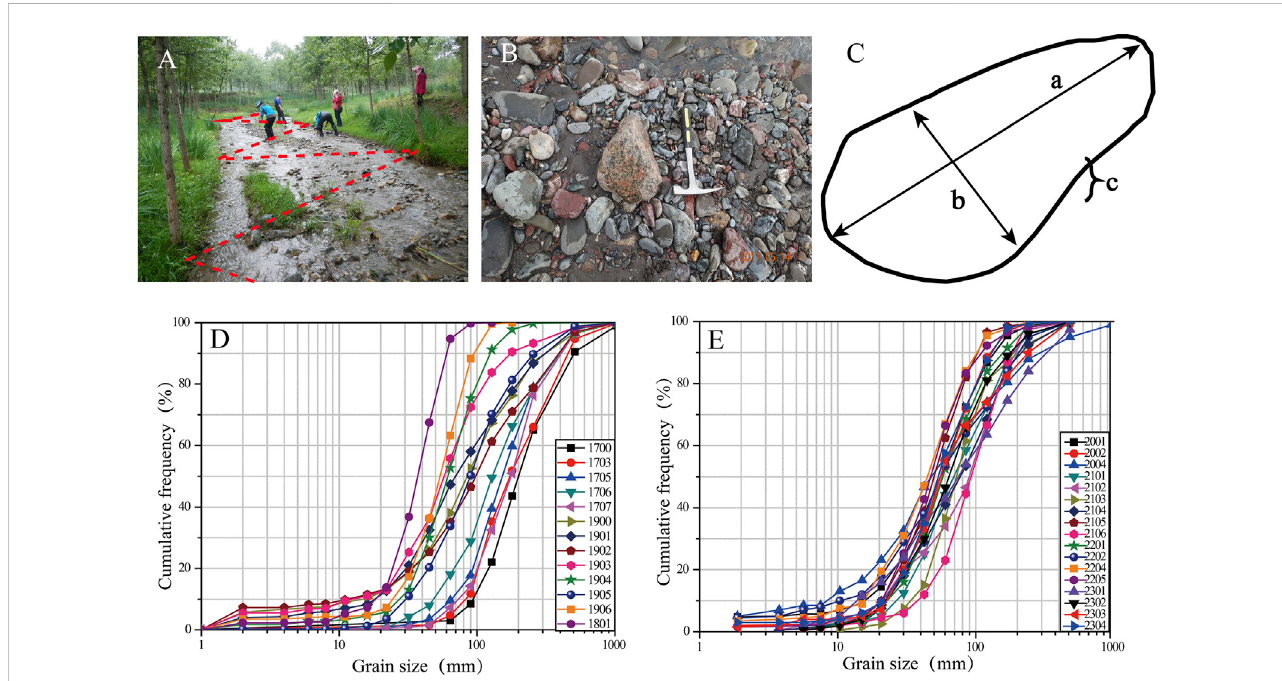
FIGURE 2 Diameter measurement method and fi eld photographs of channel sediments. (A,B) show fi eld survey methods and photos; (C) : Measuring shaft “ B ” axis; (D,E) indicate frequency accumulation curves of the